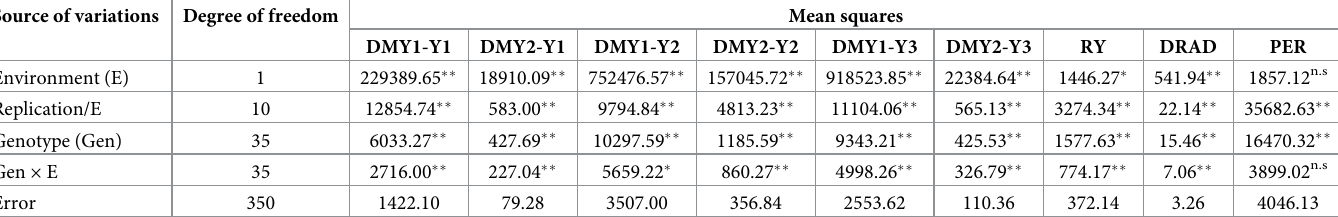
Table 1. Combined analysis of variance for measured traits in 36 genotypes of smooth bromegrass evaluated under two moisture regimes (normal and water deficit). Source of variations Degree of freedom Mean